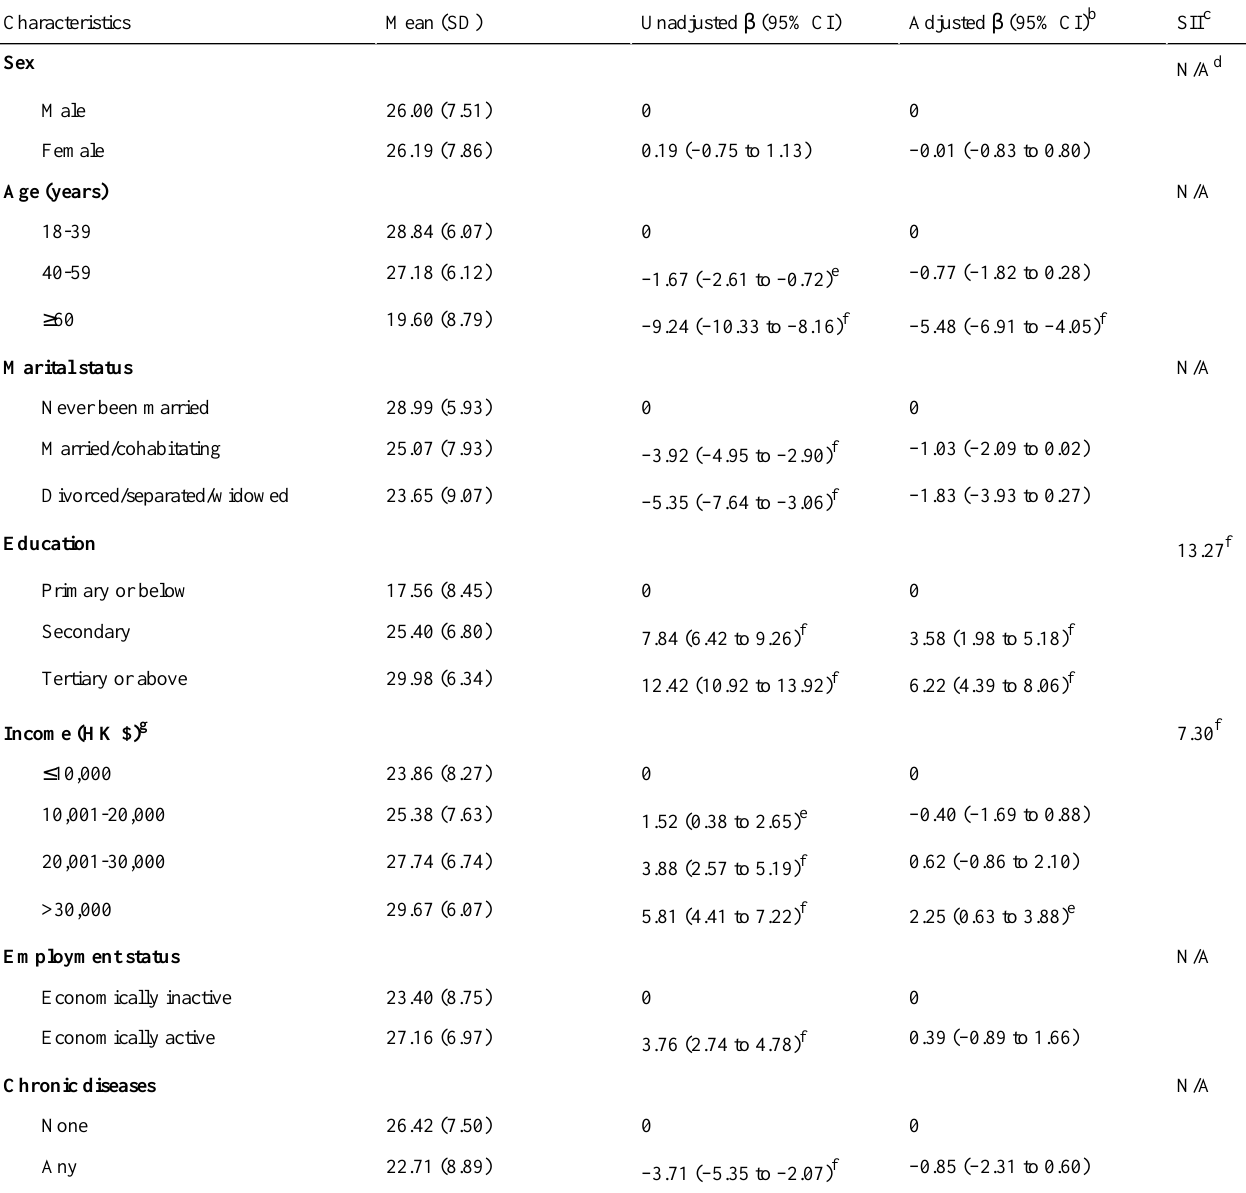
Table 3. Associations among demographic variables, socioeconomic status, and chronic diseases with the eHealth literacy score a among participants seeking web-based information on COVID-19